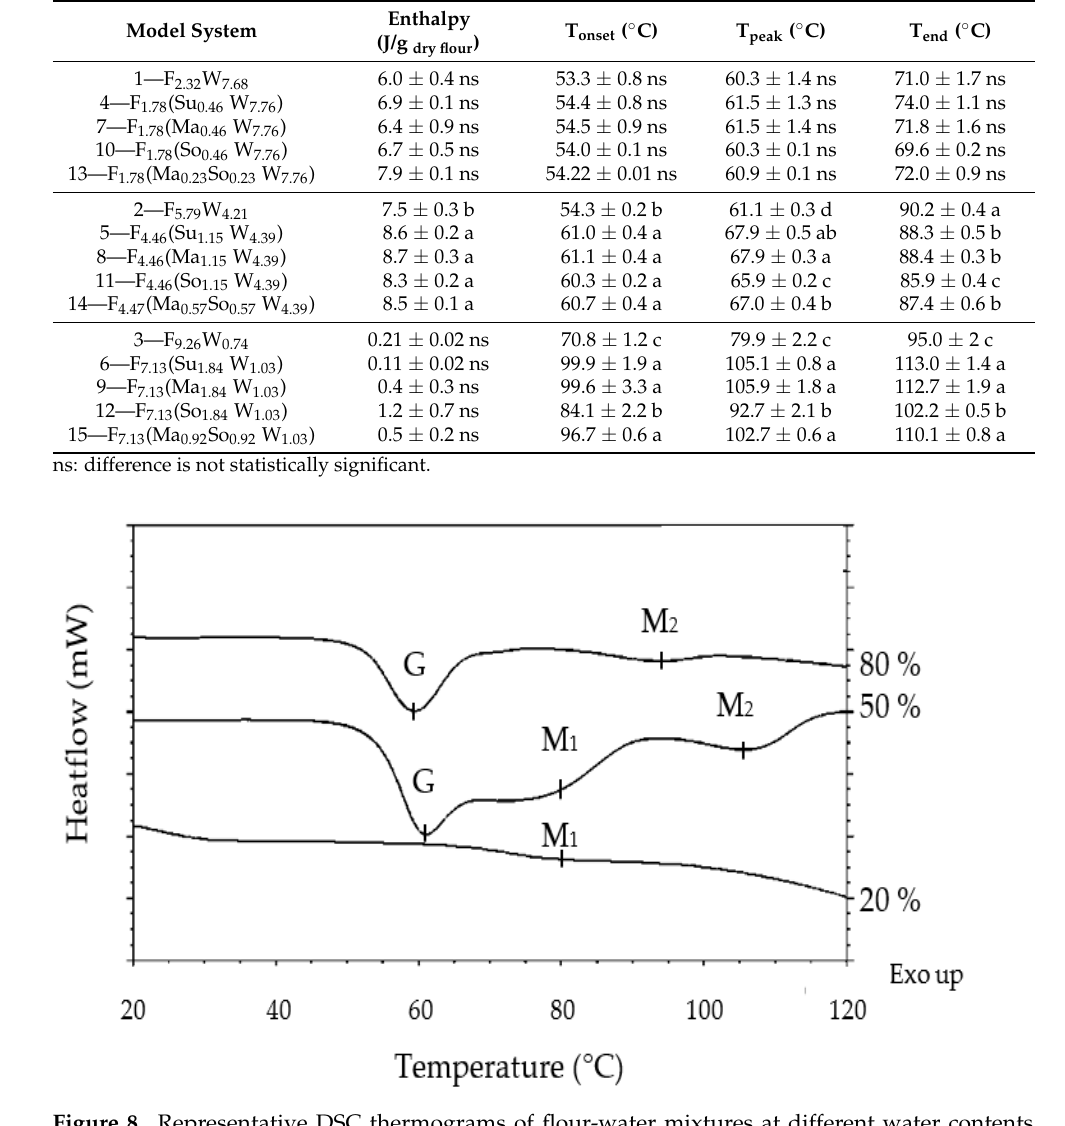
Table 6. Starch gelatinization enthalpy (J/g dry fl our) and temperatures (°C) (n= 3). Di ff erent le tt ers within the same column for the same water content re fl ect signi fi cant di ff erences (Duncan test, α = 5%).